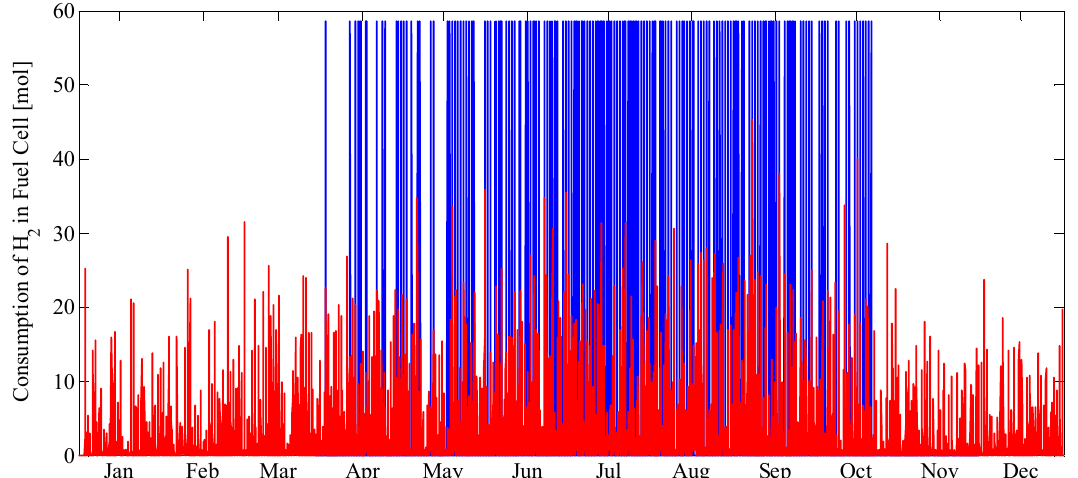
Figure 8. Full (Blue) and partial power mode (Red) of the fuel cell. Full operation has fix quantity hydrogen consumption.